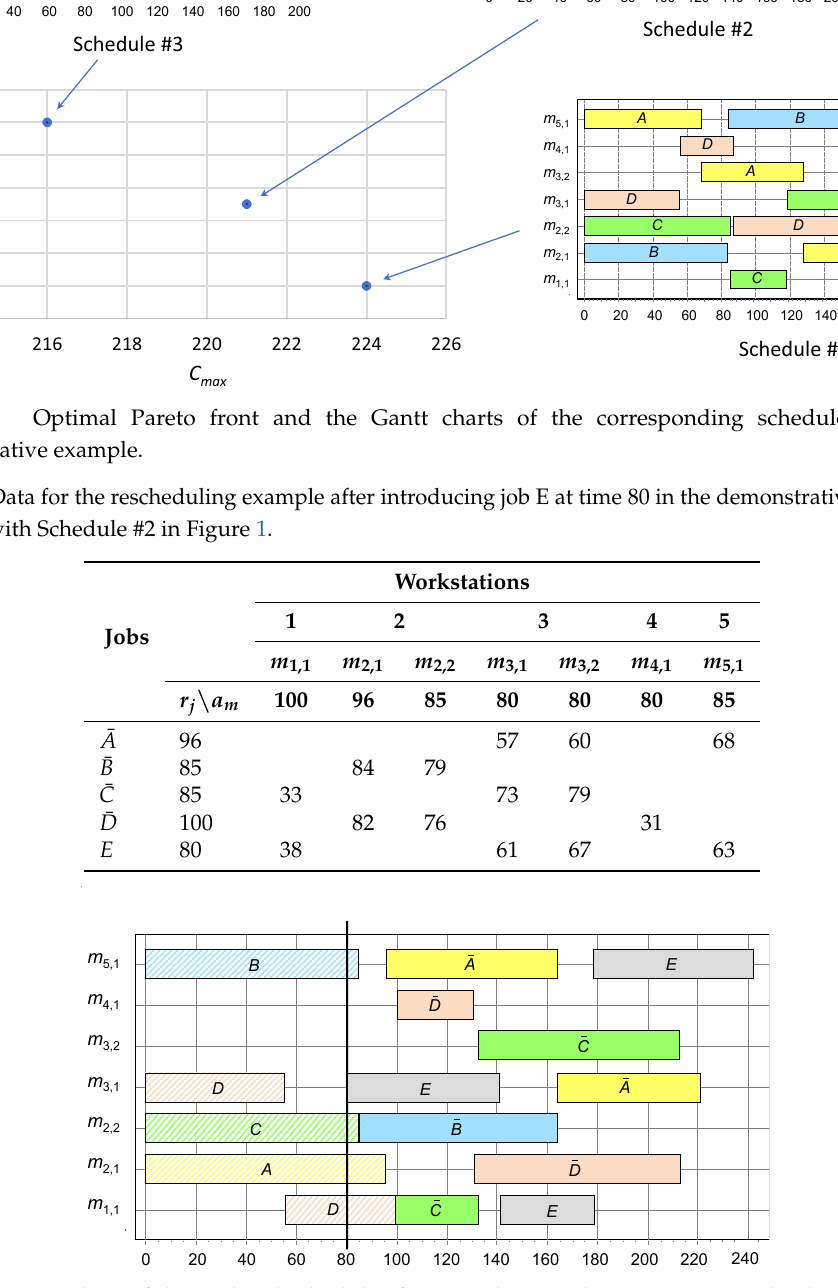
Figure 2. Gantt chart of the updated schedule after introducing job E at time 80 in the demonstrative example starting with Schedule #2 in Figure